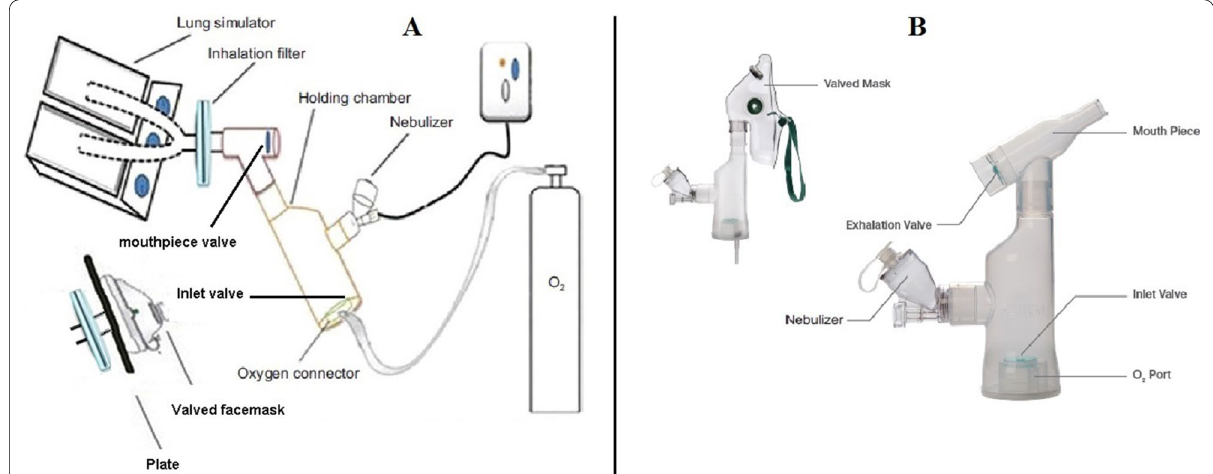
Fig. 1 A A schematic diagram of the experimental setup for determining the amount of aerosol released (the total inhalable aerosol dose) and B a picture of the used holding chamber and the vibrating mesh nebulizer setting with the mouthpiece and the valved